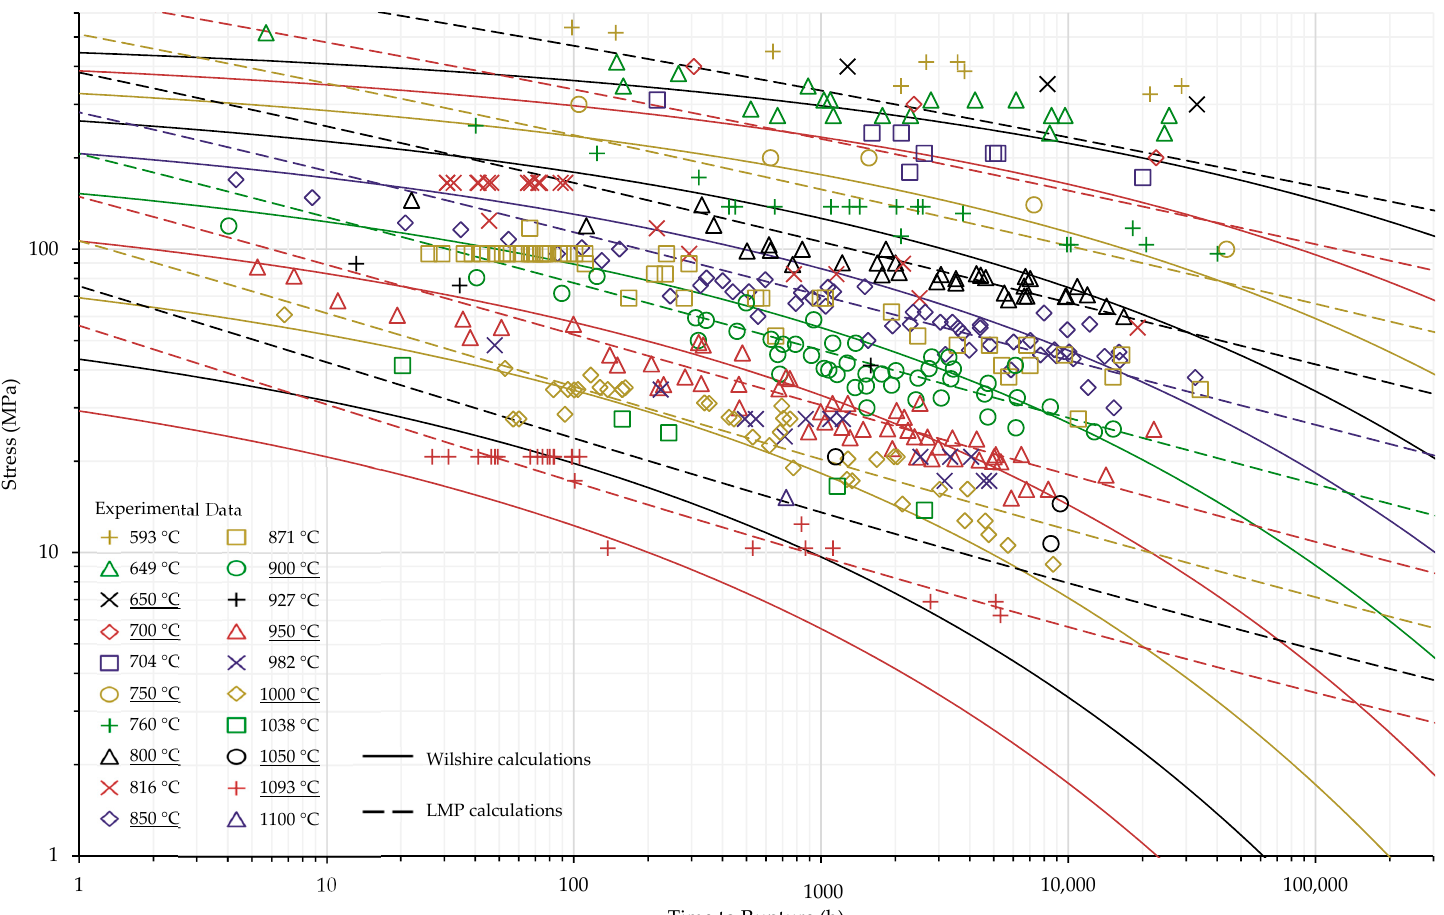
Figure 13. Calculated rupture times for Inconel 617 shown at underlined temperatures.